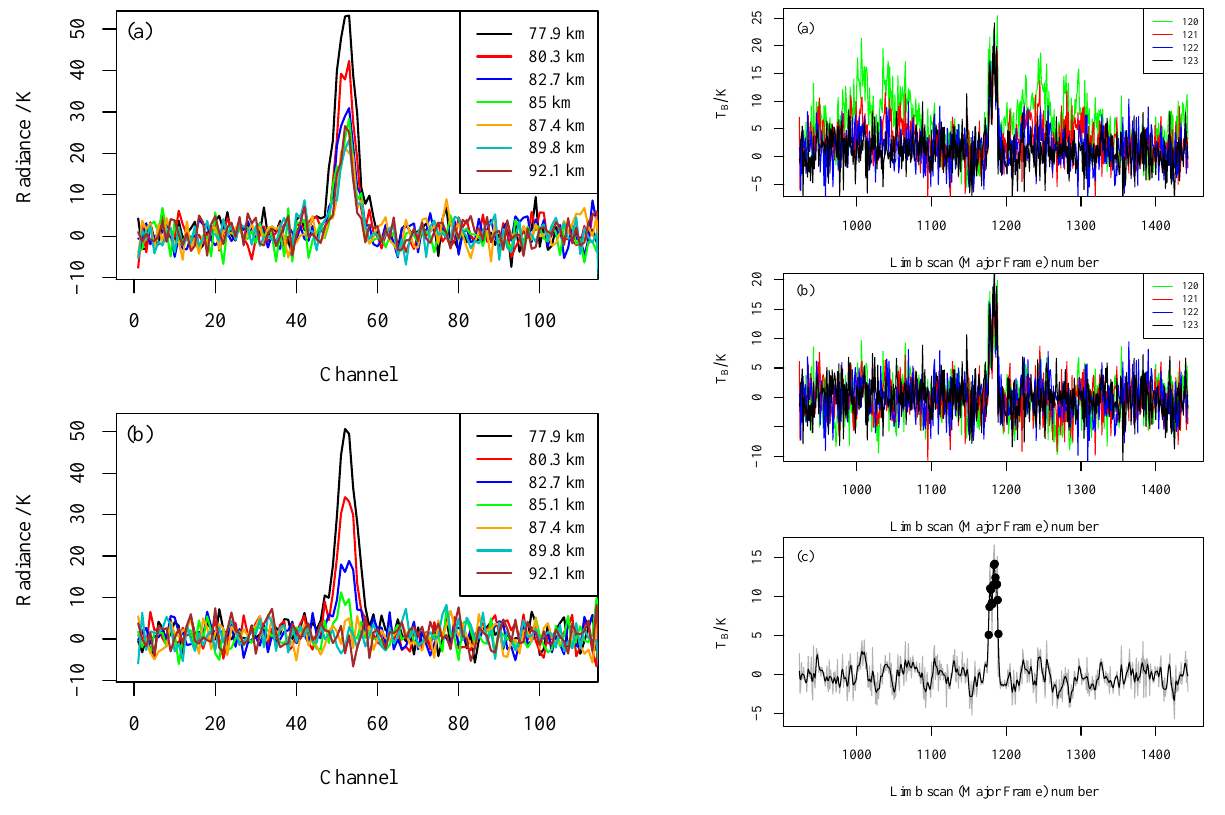
(12 launches out of 19) but the detection is marginal for two or three of these. The probability of detecting a smaller launch appears to be rather